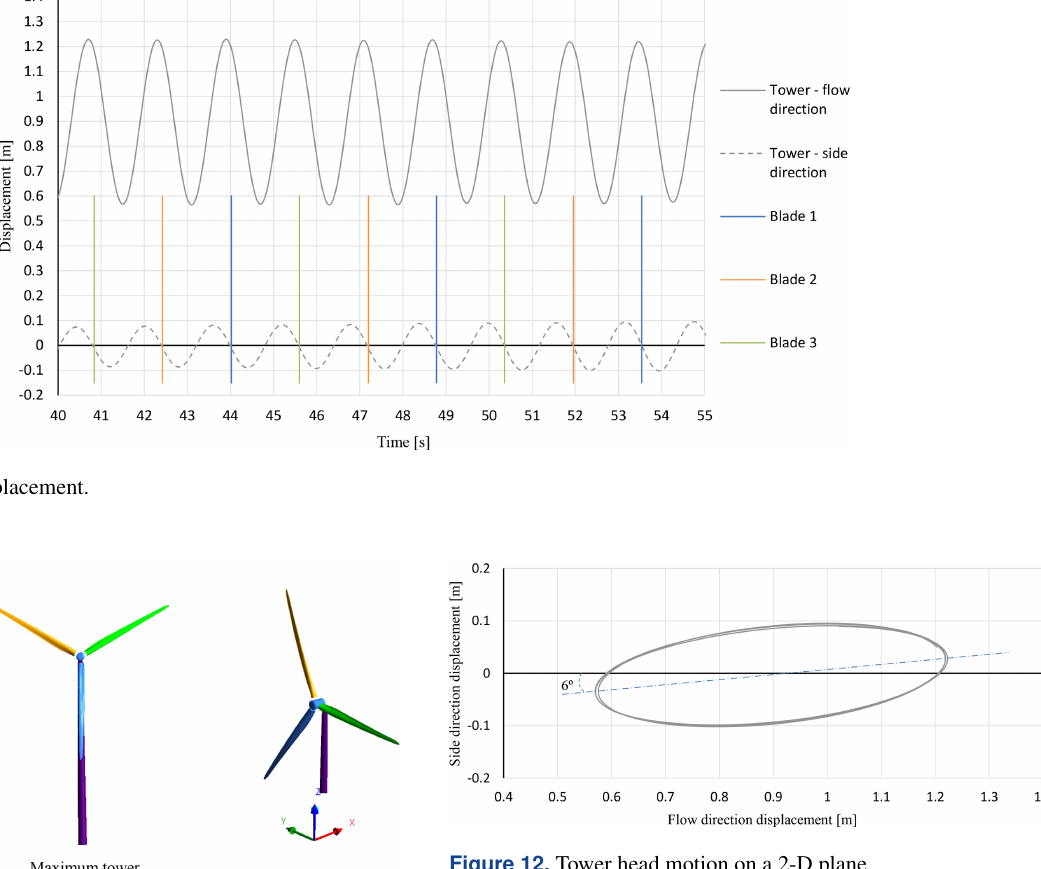
Figure 12. Tower head motion on a 2-D